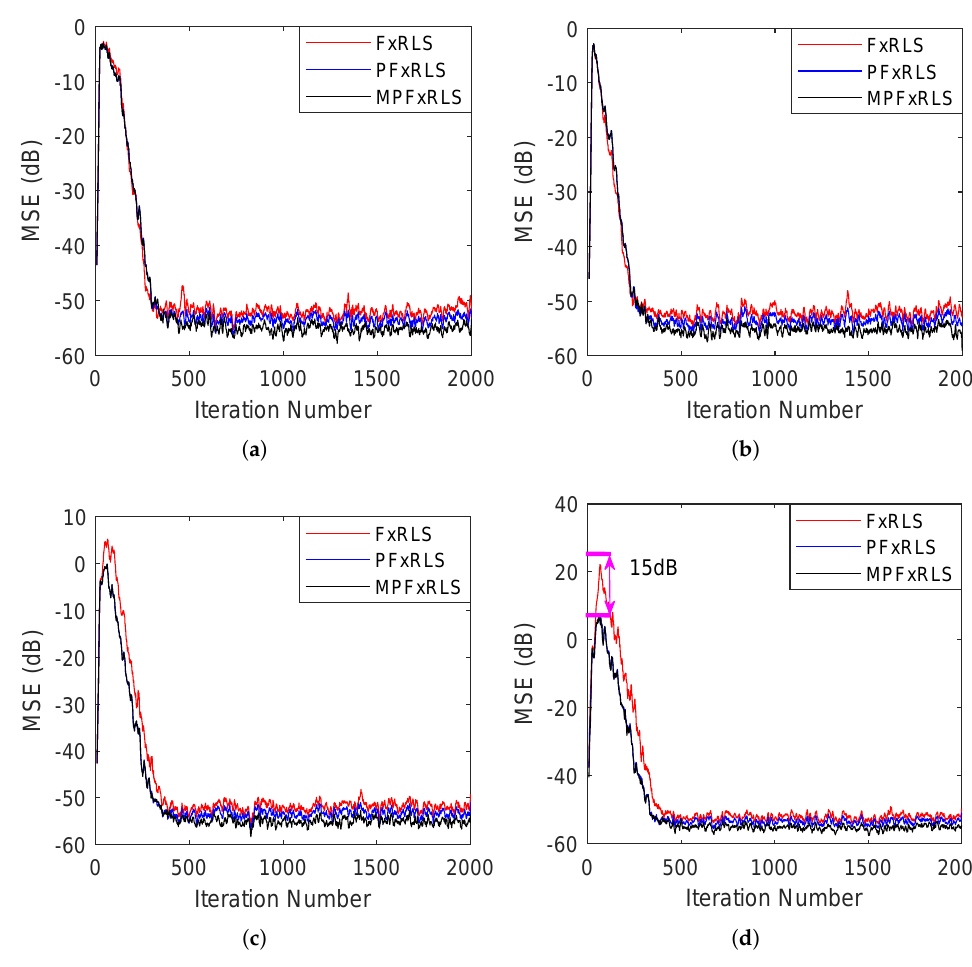
Figure 3. The sensibility evaluation of initial gain δ : ( a ) shows the MSE learning curves of δ = 10 − 4 . ( b ) shows the MSE learning curves of δ = 10 − 2 . ( c ) shows the MSE learning curves of δ = 1. ( d ) shows the MSE learning curves of δ = 10 2 . Table 2. Steady-state MSE of FxRLS, PFxRLS and MPFxRLS with different parameters